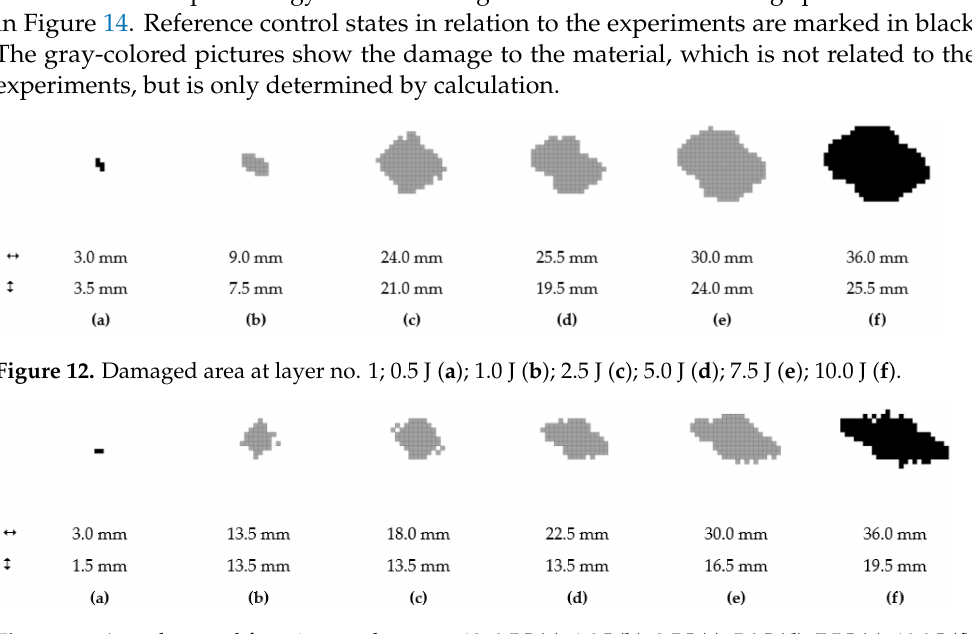
Figure 13. Area damaged from impact; layer no. 12; 0.5 J ( a ); 1.0 J ( b ); 2.5 J ( c ); 5.0 J ( d ); 7.5 J ( e ); 10.0 J ( f ).